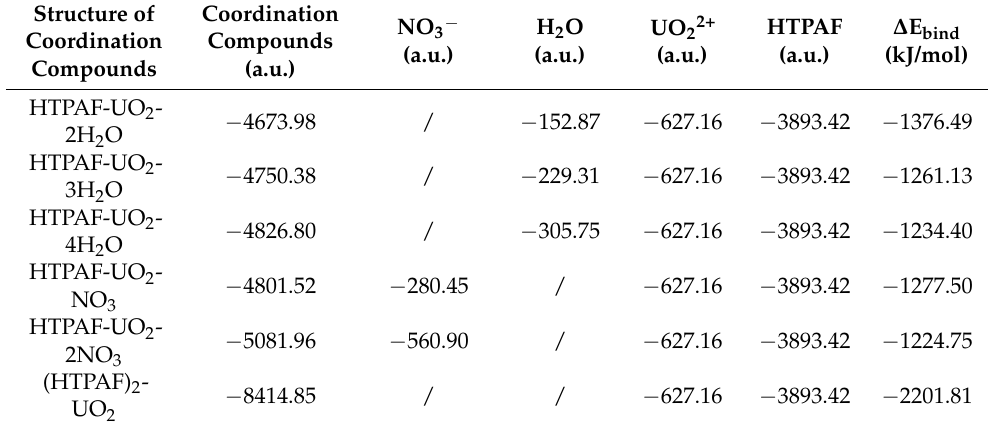
Table 1. The binding energy of coordination compounds formed by HTPAF and UO 22+ . Structure